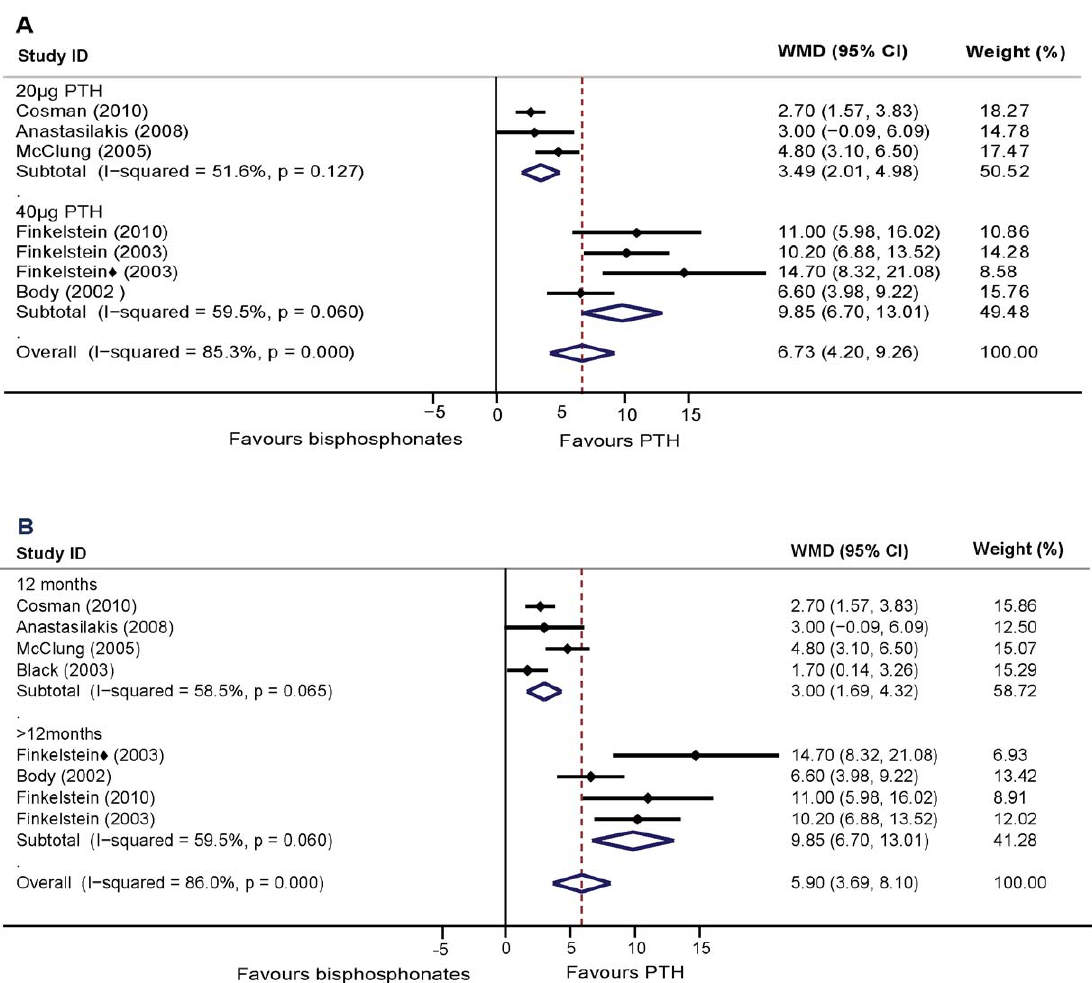
Figure 2. Assessment of the effects of PTH versus bisphosphonates on BMD of the lumbar spine. A: Subgrouped analysis of dosage of PTH (1–34) versus bisphosphonates treatment on spinal BMD. B: Subgrouped analysis of the duration of PTH (1–34) versus bisphosphonates treatment on spinal BMD. X : The study reported BMD data in lateral spine.